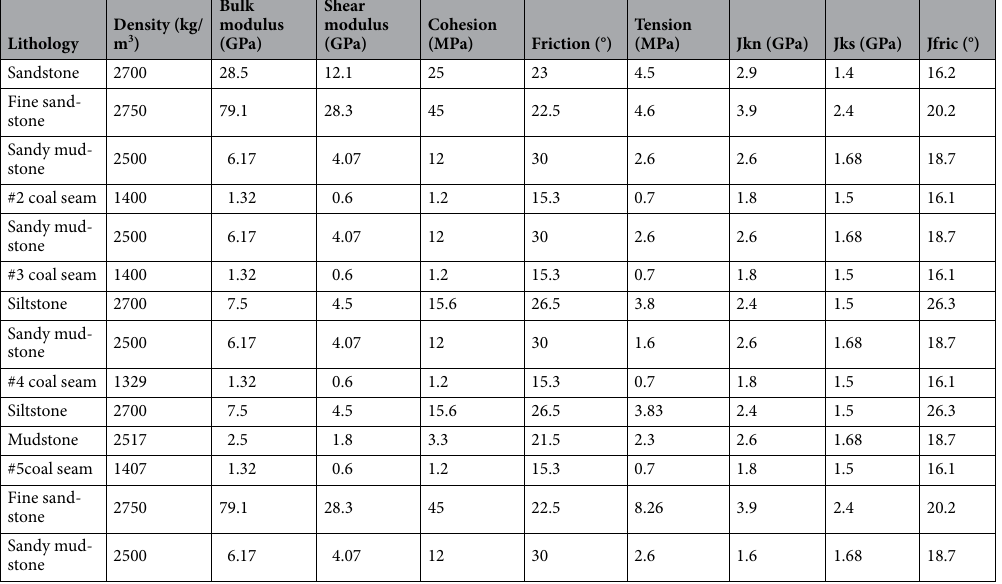
Table 1. Physico-mechanical properties of the